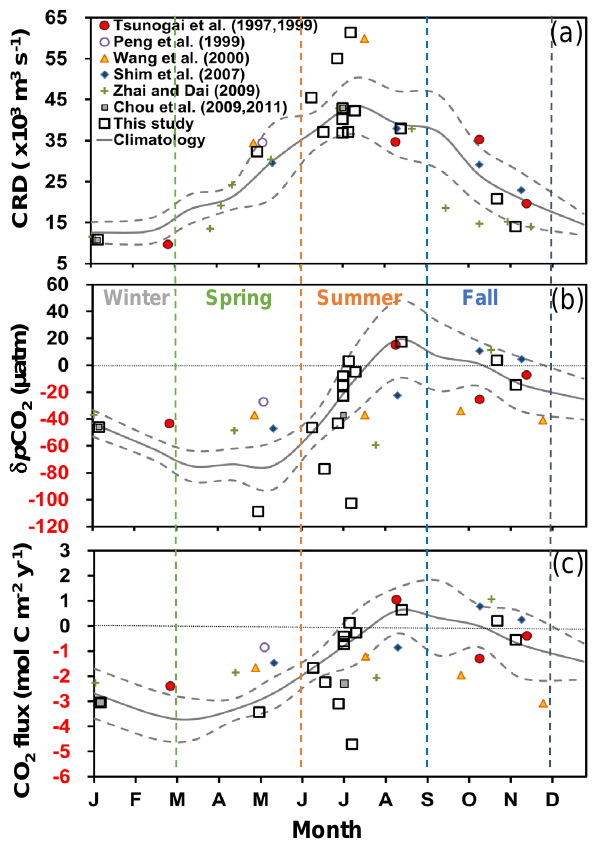
Figure 9. Seasonal monthly patterns revealed in observational data of (a) CRD, (b) δp CO 2 and (c) air–sea CO 2 flux, obtained from published references and from field data in this study and model results. The thick curves denote the climatological mean and the dashed curves denote the range of ± 1 SD during the study period of 1998–2011.